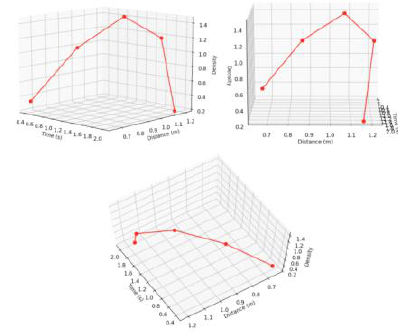
Figure 16. 3D Graph of Cigarette Smoke Density vs Time vs Extent Relative from the Source in an Indoor